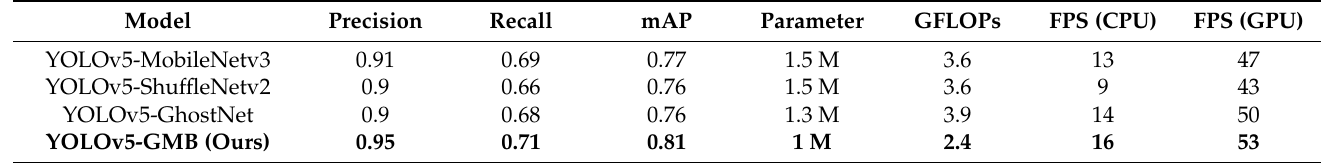
Table 3. Comparison of multiple lightweight algorithms on spacecraft datasets.